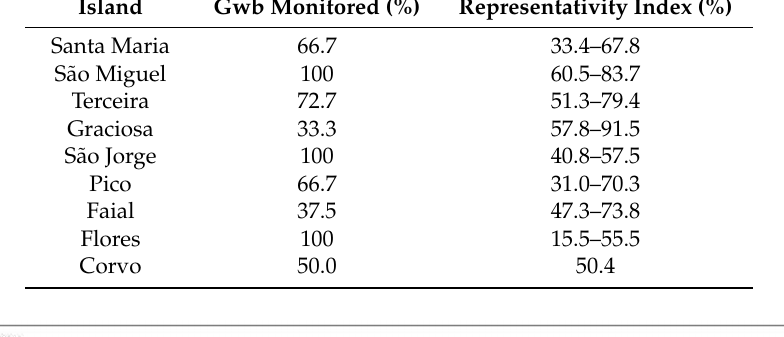
Table 1. Representative index for the chemical status monitoring networks in the Azores RBD. Island Gwb Monitored (%)